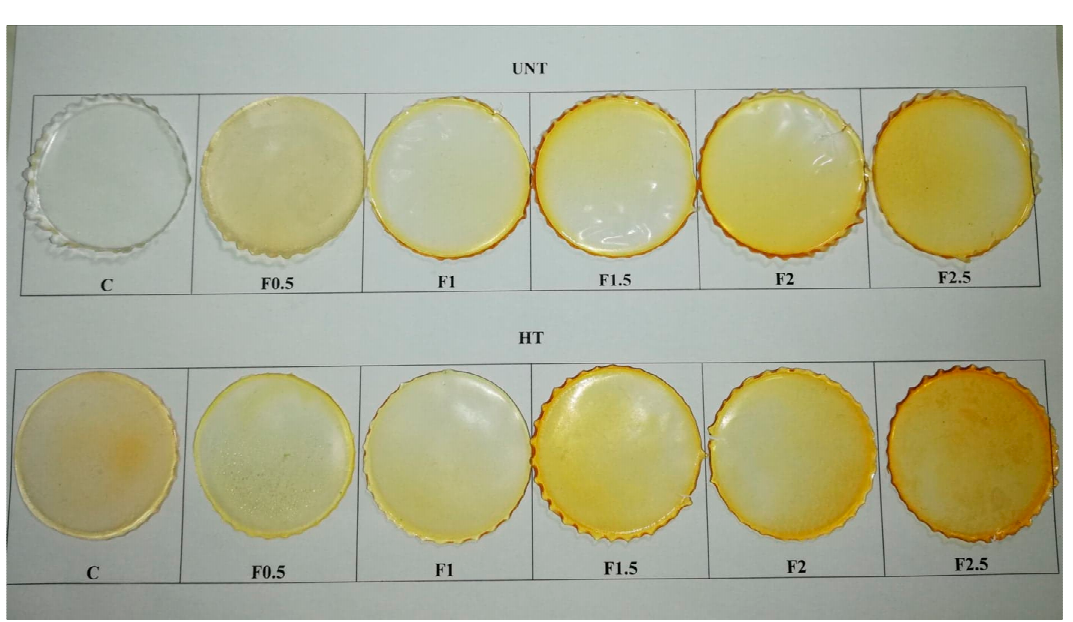
Figure 1. Surface images of UNT and HT formulations. C-control film; F0.5-film with 0.5% tarragon essential oil; F1-film with 1% tarragon essential oil; F1.5-film with 1.5% tarragon essential oil; F2-film with 2% tarragon essential oil; F2.5-film with 2.5% tarragon essential